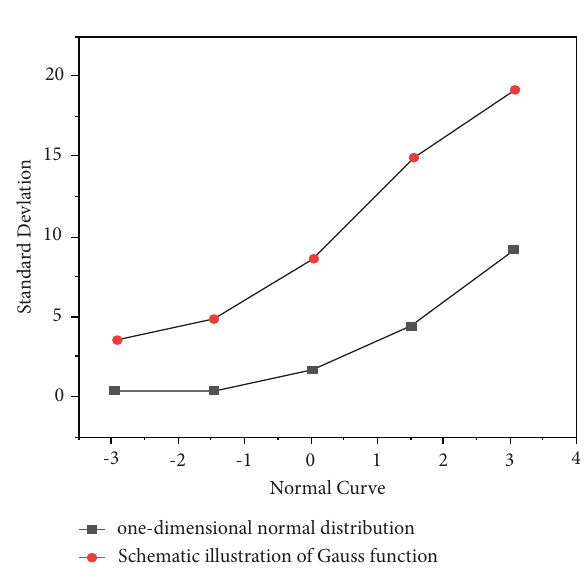
Figure 6: Schematic diagram of Gaussian function.